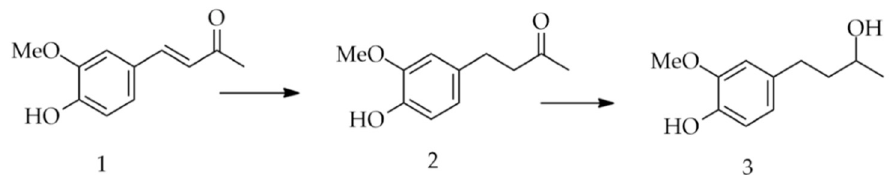
Figure 5. Molar percentages of reagent and products vs. time of zingerone hydrogenation reaction.